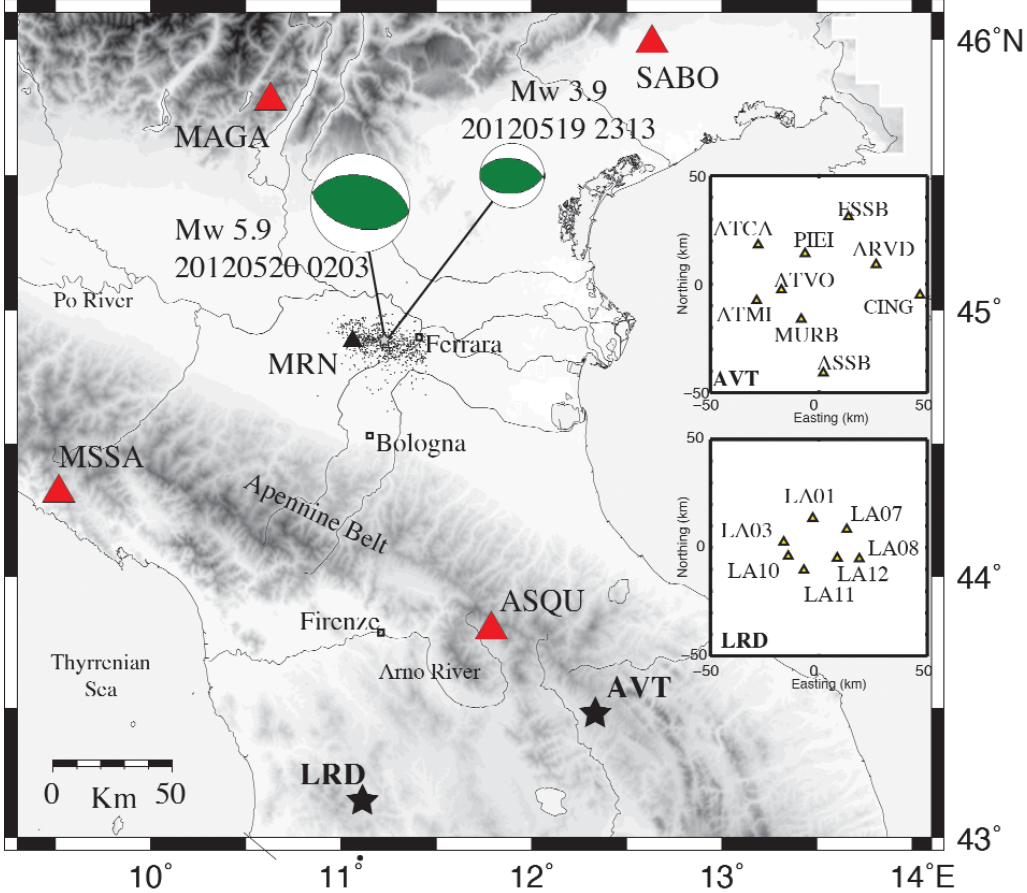
Figure 1. Map of the study area. Red triangles, locations of the four INGV stations used to calculate the relative source time functions; black triangle, lo- cation of the MRN accelerometer; black stars, locations of the two arrays, the geometries for which are illustrated in the two insets; black dots, aftershocks located during the first week following the May 20, 2012, mainshock; beach balls, focal solutions for the mainshock and the foreshock, as reported by the Time-Domain Moment Tensor catalog [Scognamiglio et al. 2009; see also http://cnt.rm.ingv.it/tdmt.html]. The foreshock signal is used as the EGF (see text for details).